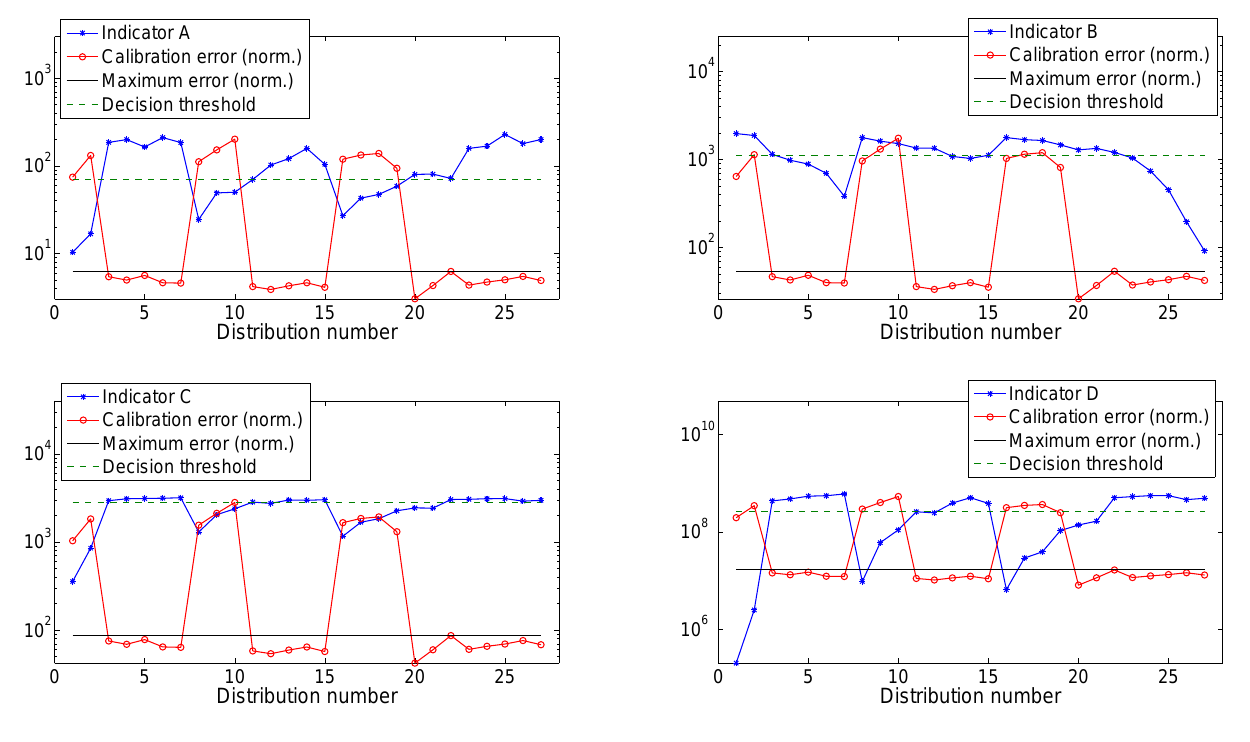
Figure 4. Dataset 1: Indicators vs . normalized calibration